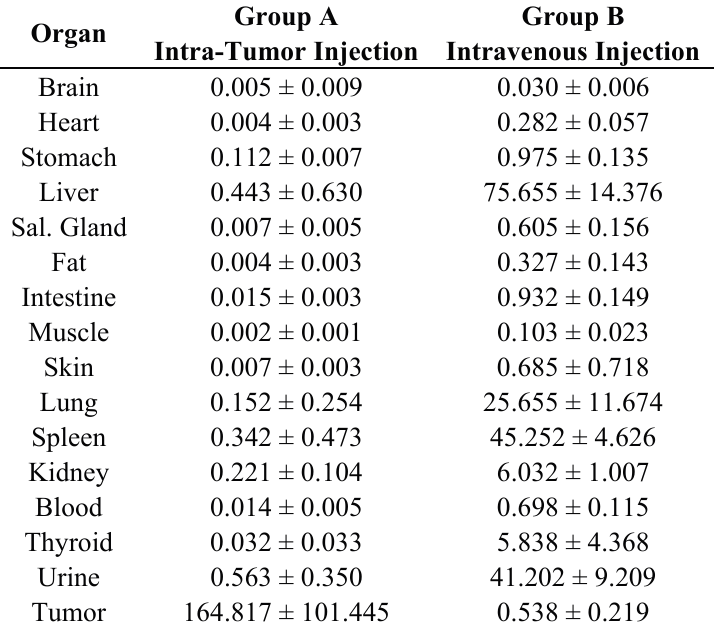
Table 1. 99m Tc radioactivity in organs after intra-tumor or intravenous injections in